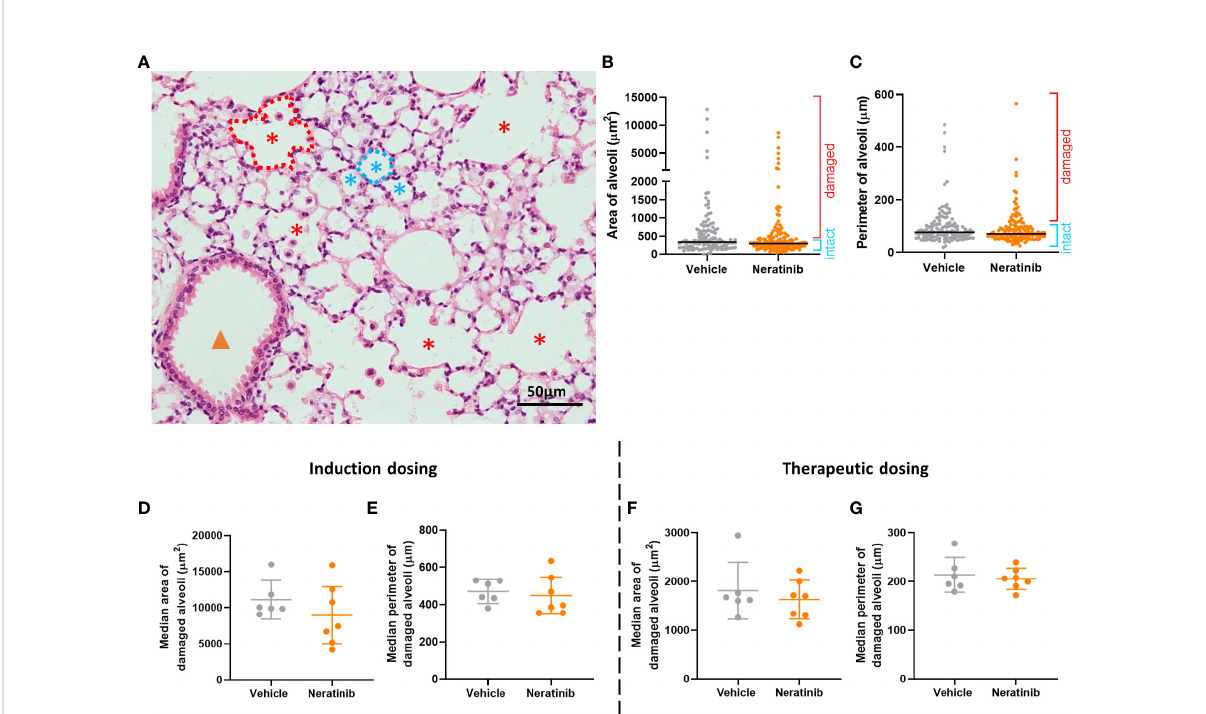
FIGURE 6 Neratinib does not alter alveolar area or perimeter in chronic mouse models of lung disease. Fixed mouse lung tissue slices were stained with H&E (A) . Alveoli were identi fi ed by a lumen surrounded by characteristically thin squamous epithelial cells and classi fi ed as intact (blue stars) or damaged (red stars) and differentiated from bronchioles (orange arrowhead) as described in the Materials and methods . Area and perimeter measurements were calculated using the outline tool (dotted lines) in NIS-Elements. Initially, random alveoli were selected for analysis; however, this resulted in the majority measured being intact (B, C) . Each dot represents one alveolus, line at median; 20 alveoli measured across two lung slices per mouse, in the induction dosing study. To assess only damaged alveoli, a lower threshold of 500 m m 2 for area and 75 m m for perimeter was set, and alveoli below these sizes were excluded from the analysis. Median damaged alveolar area and perimeter per mouse were assessed, and no differences between treatment groups were found with either the induction dosing protocol (D, E) or the therapeutic dosing protocol (F, G) . (D – G) Each dot represents one median alveolar area/perimeter per mouse, calculated from 20 alveolar measurements across two lung slices. Bars show mean ± standard deviation. Unpaired t -test was used to compare treatment